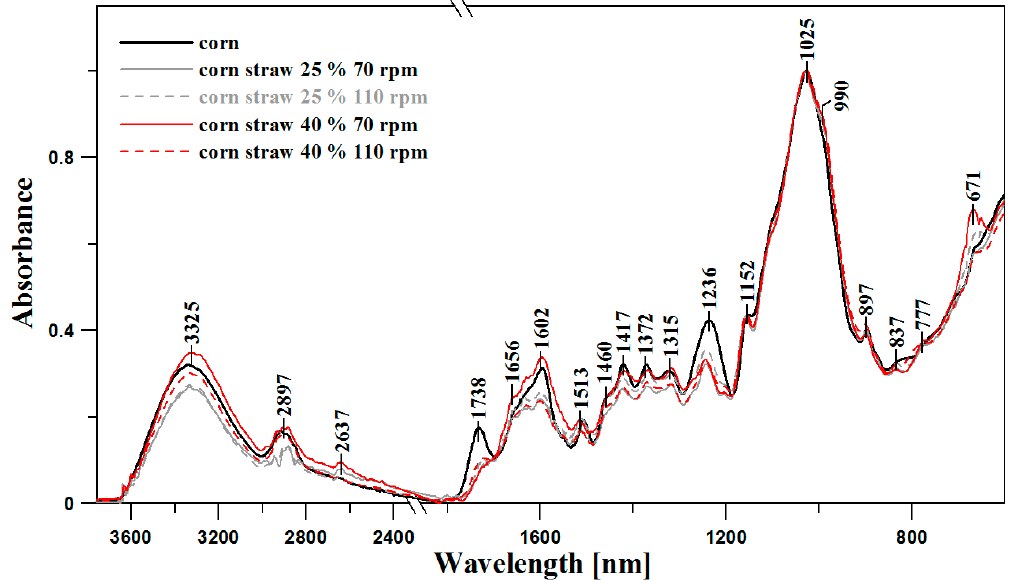
Figure 6. Normalized FTIR infrared spectra for samples of: corn, corn straw 25% and 70 rpm, 25% and 110 rpm, and corn straw 40% and 70 rpm and 40% and 110 rpm for the spectra of 3750–600 cm − 1 . As reported by Kondo [42], Liang et al. [43] or Hospodarova et al. [44], the first very characteristic